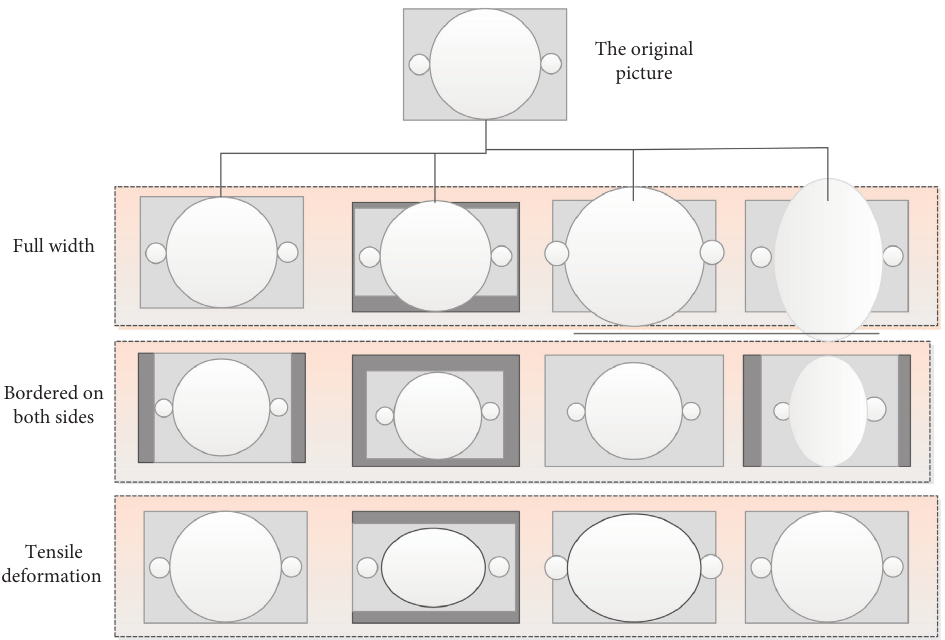
Figure 6: Distortion diagram of original